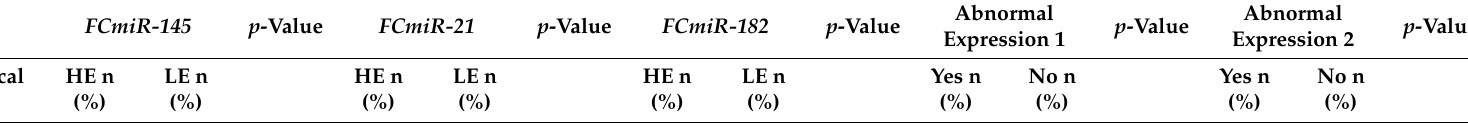
Table 1. Di ff erences in expression level of selected miRNAs in the patients’ group according to clinicopathological parameters. FCmiR-145 p -Value FCmiR-21 p -Value FCmiR-182 p -Value Clinicopathological